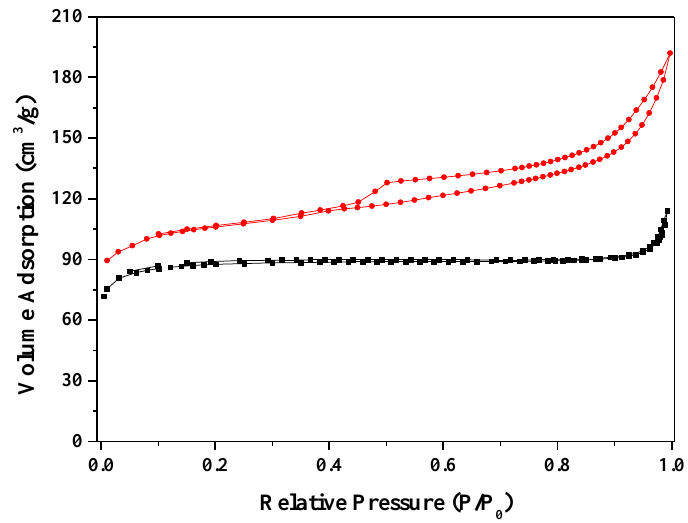
Figure 4. N 2 sorption isotherms of ( a ) RUB-37 and ( b ) Sn-JHP-2.